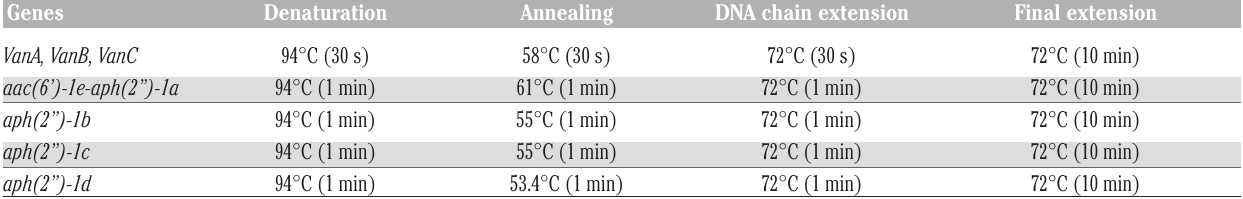
Table 2. The steps and temperatures in polymerase chain reaction amplifications.